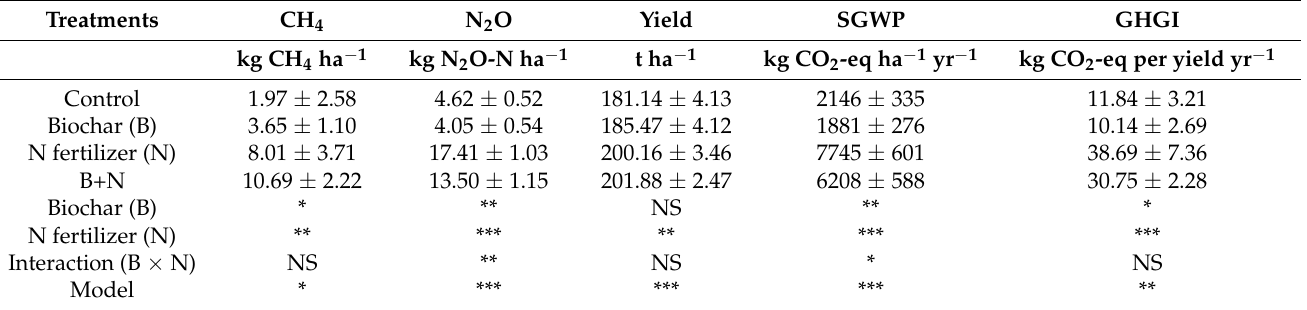
Table 3. Annual CH 4 and N 2 O emissions, vegetable yield, net SGWP and GHGI as affected by biochar and N fertilizer. 194